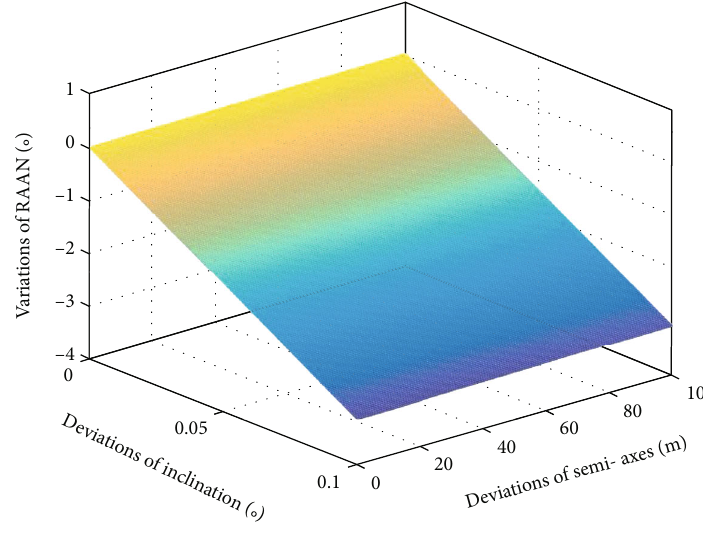
Figure 3: Variations of RANN.